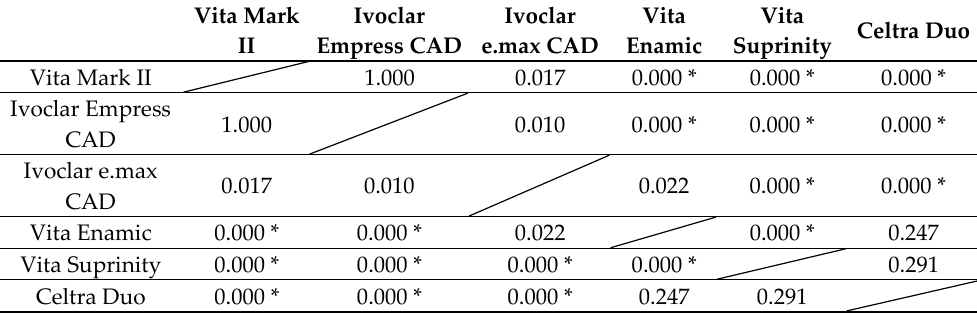
Table A10. Comparison of the different ceramics during the pull-off test: Fuji Cem.